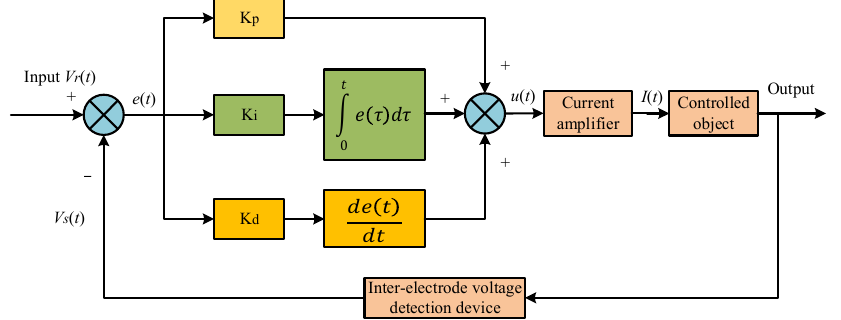
Figure 4. Structure diagram of the conventional PID controller.